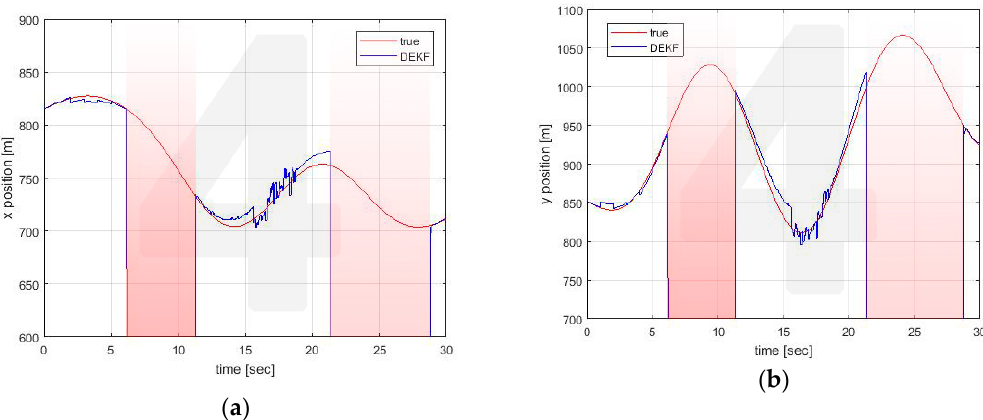
Figure 7. Position estimation performed by Vehicle 1 on Vehicle 4 position ( a ) x axis ( b ) y axis.